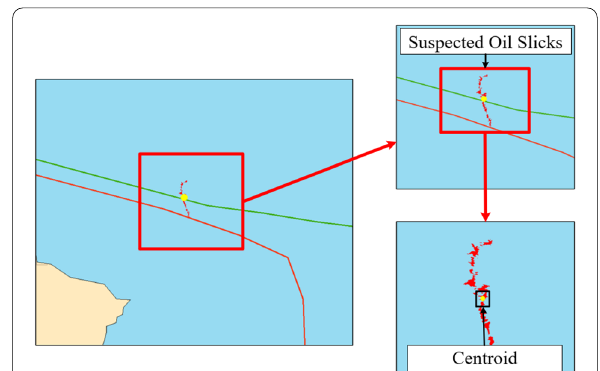
Fig. 8 Centroid extraction of suspected oil films